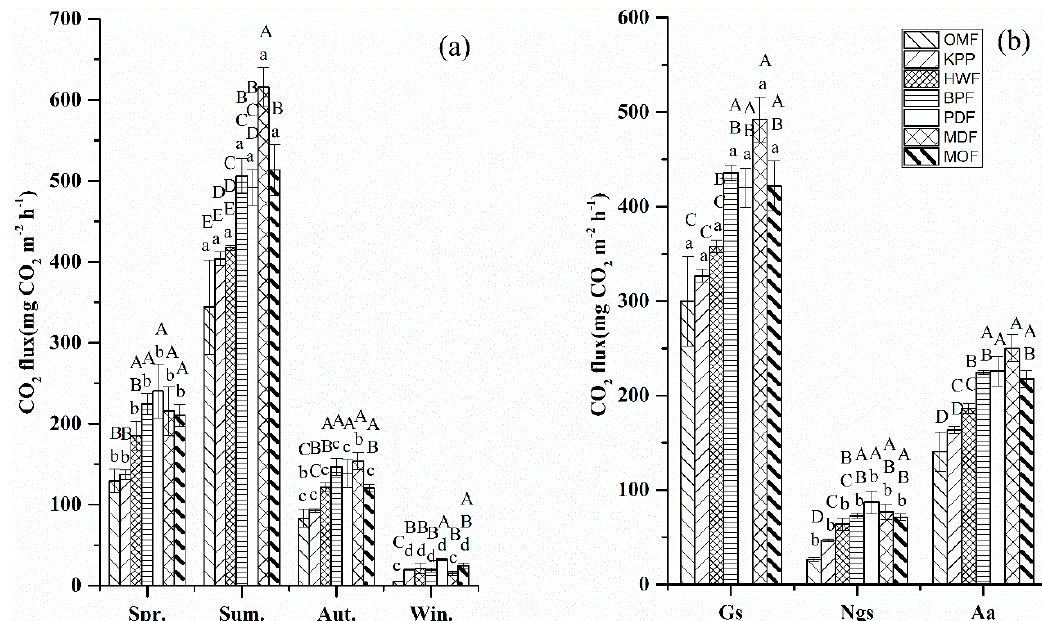
Figure 3. Seasonal variations ( a ), dynamics of Gs and Ngs ( b ), and the annual average ( b ) of carbon dioxide emissions from the over-mature forest, Korean pine plantation, and five secondary forests at the Maoershan Ecosystem Research Station in Northeast China. See Figure 2 for the explanation of the different lowercase letters and capital letters and the different abbreviations.